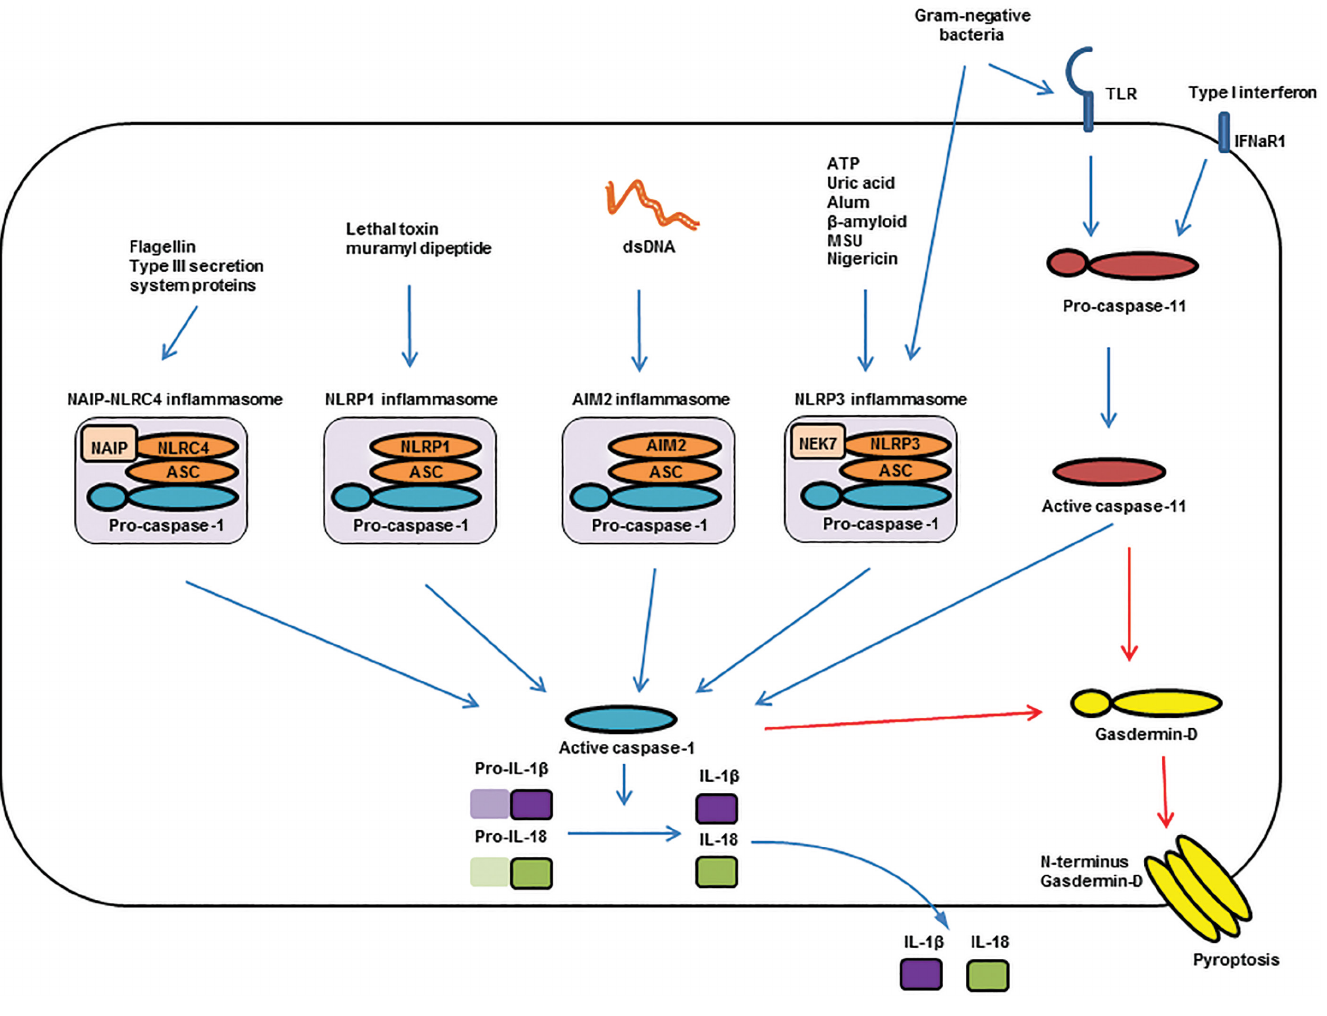
Figure 1. Canonical and noncanonical inflammasomes. A typical inflammasome contains a sensor protein belonging to either the NLR or ALR family of pattern recognition receptors, an adaptor protein ASC and pro-caspase-1. NAIP-NLRC4 is activated by bacterial flagellin and type III secretion system proteins, NLRP1 is activated by lethal toxin and muramyl dipeptide, AIM2 is activated by cytosolic dsDNA and NLRP3 is activated by a variety of activators including ATP, uric acid, alum, β -amyloid, MSU and nigericin. Activation of these inflammasome complexes results in proteolytic cleavage of zymogen pro-caspase-1 into its enzymatically active form, which then leads to maturation of proinflammatory cytokines IL-1 β and IL-18. In the noncanonical inflammasome pathway, pro-caspase-11 expression is induced by a variety of Toll-like receptor ligands, or via type I interferon signaling. Caspase-11 is self-oligomerized and activated by cyto- solic LPS, which subsequently leads to caspase-1 activation, as well as gasdermin D–mediated pyroptotic cell death in